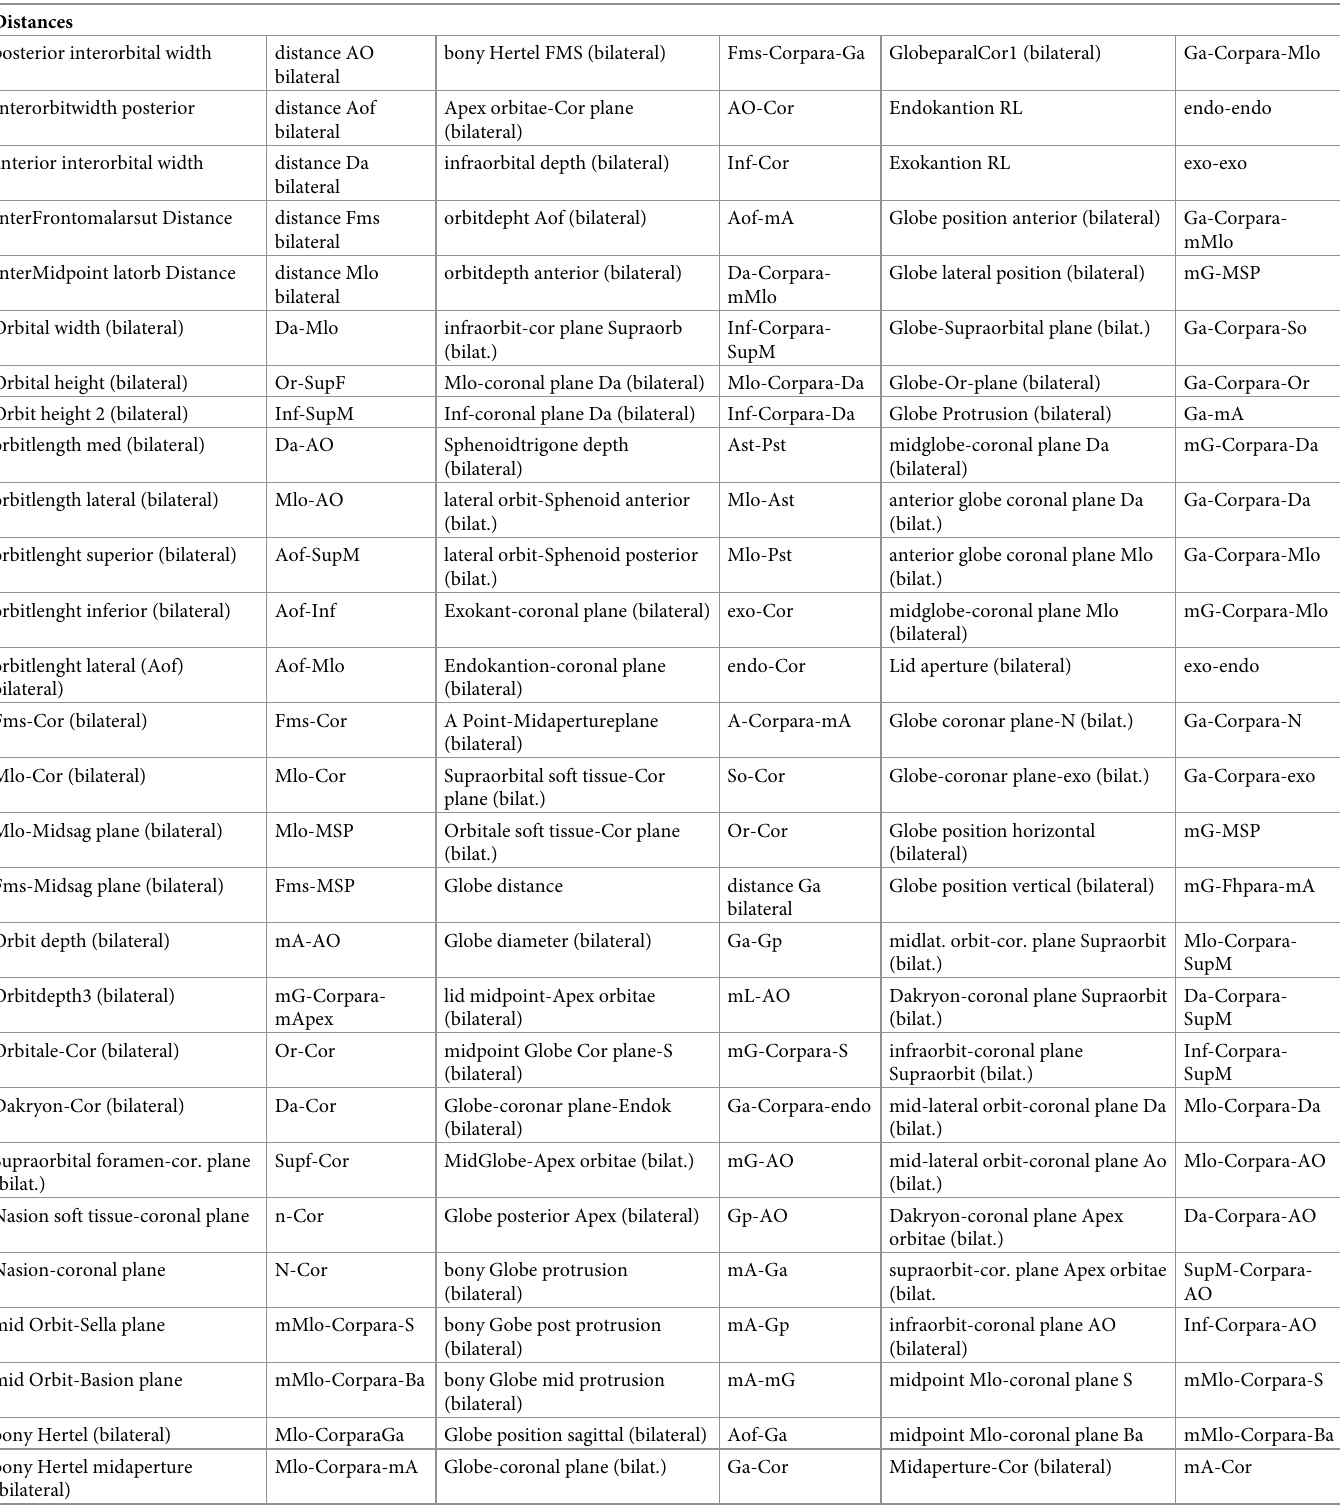
Table 2. Distances measured in the study and their